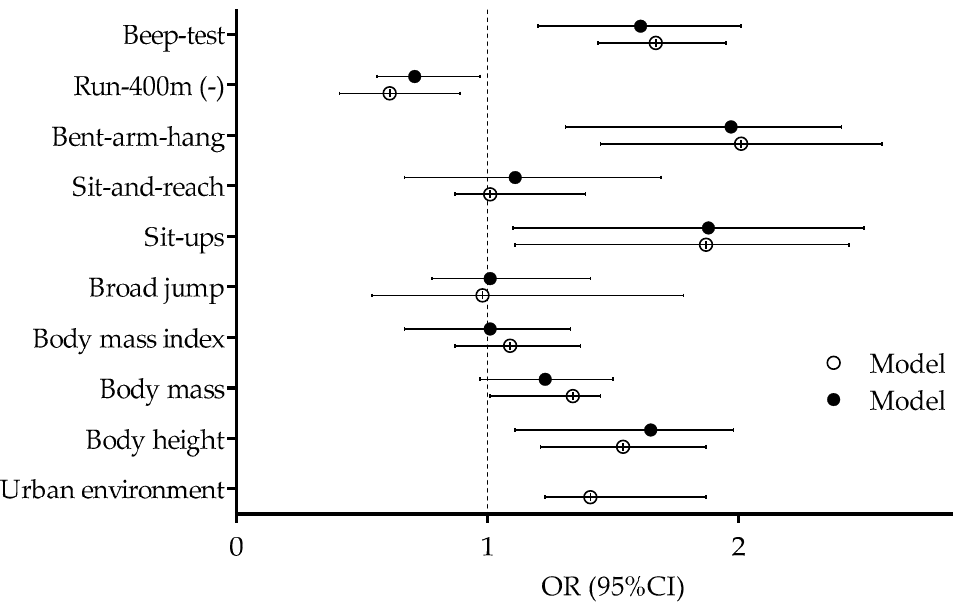
Figure 3. Predictors of normal physical activity levels at baseline (model 0 – crude logistic regression, model 1 – logistic regression controlled for urban/rural environment as confounding factor).